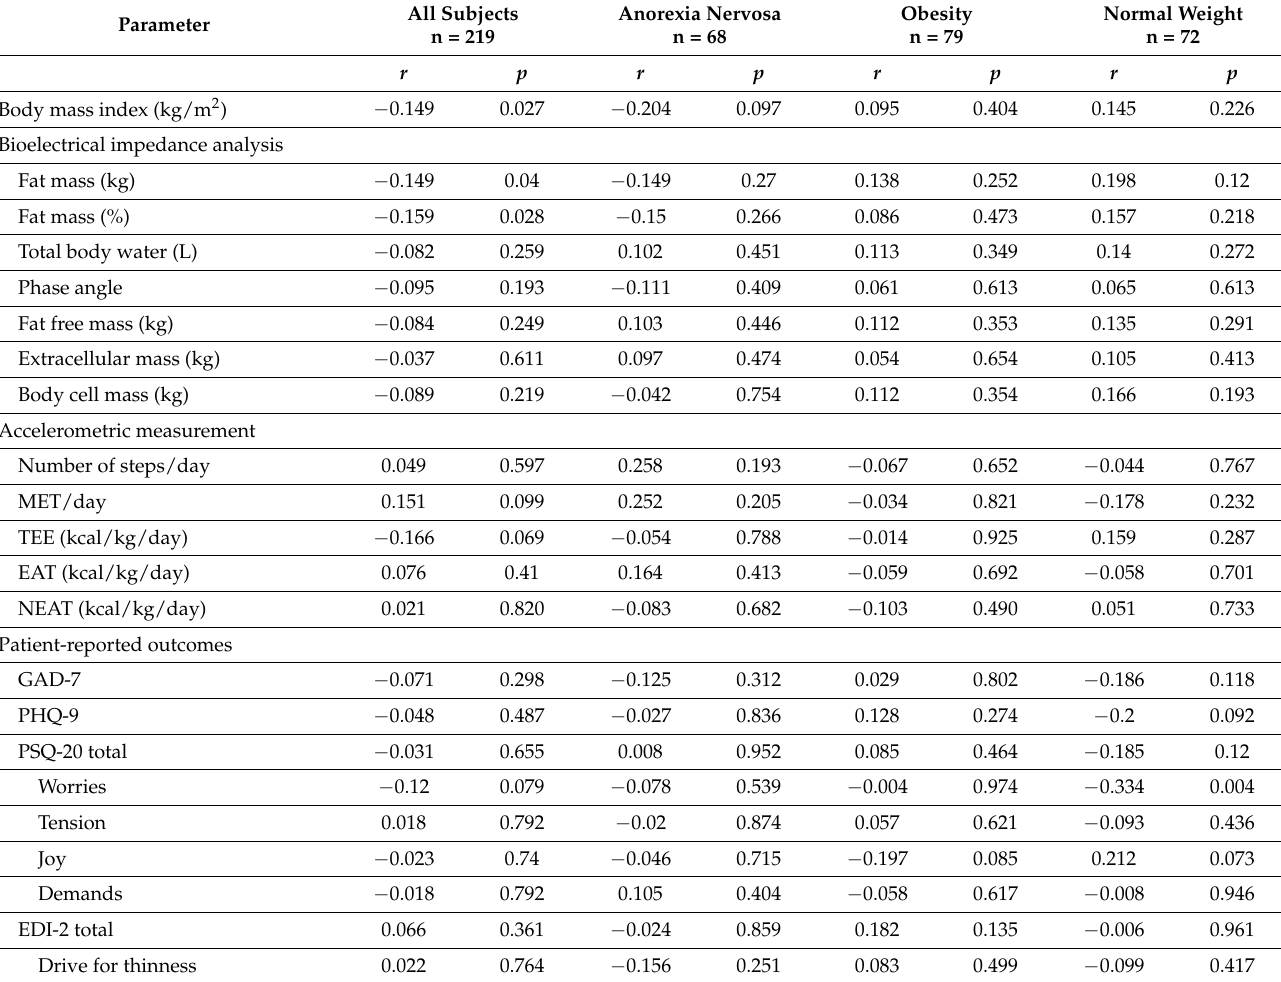
Table 3. Correlations of body mass index, body composition, physical activity, energy expenditure, and patient-reported outcomes with